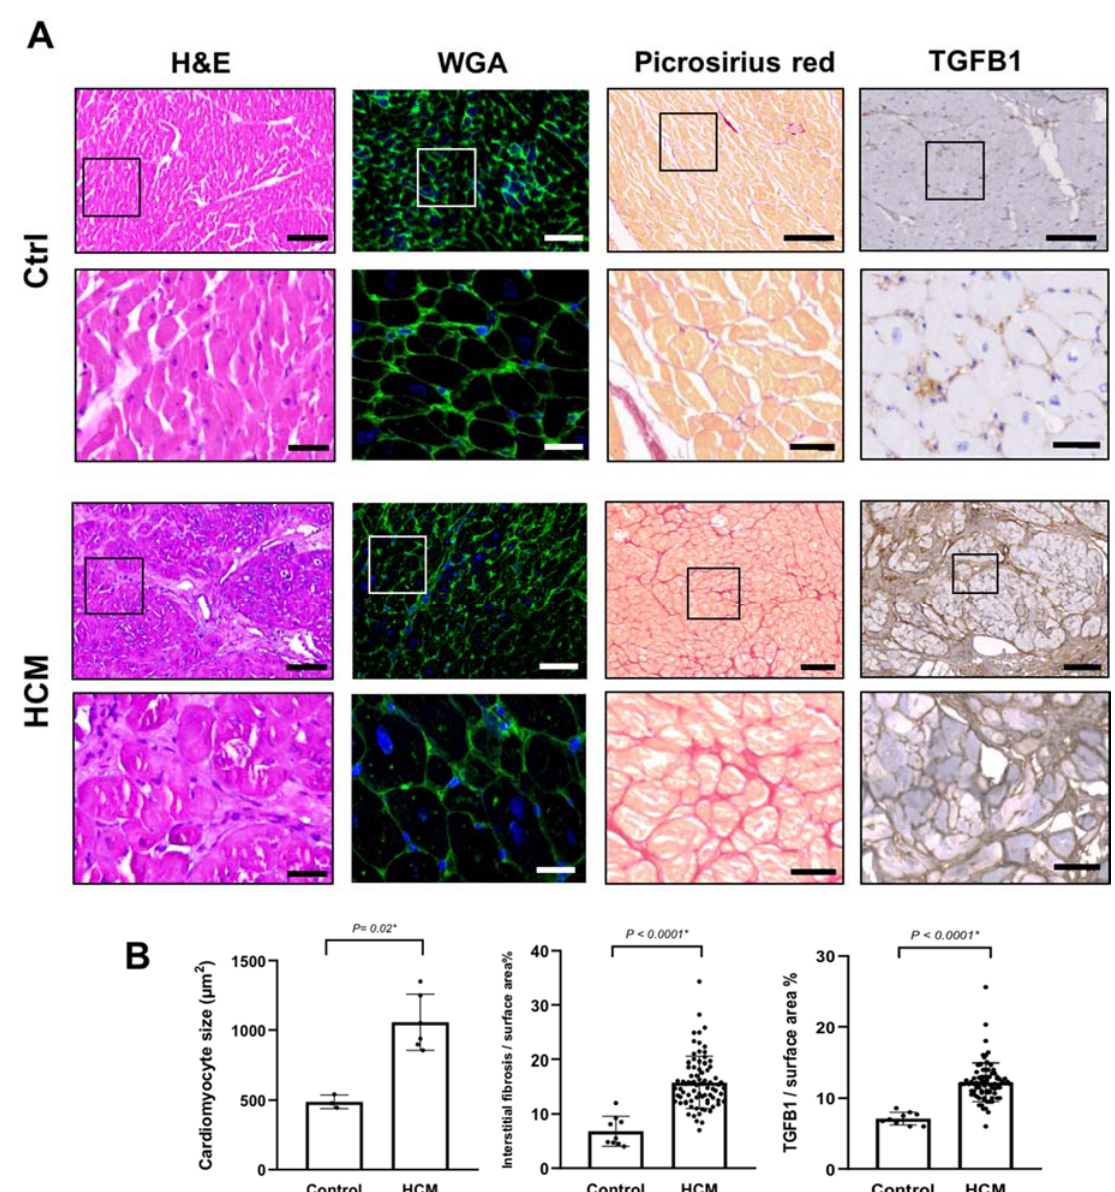
Figure 1. Histological characterization of HCM myectomy tissues ( A ) Histological characterization of HCM tissues compared to control tissues using hematoxylin and eosin (H&E) staining, WGA staining, Picro-sirius staining, and TGF β 1 expression, assessed by immunohistochemistry. Scale bars are 100 (overview) and 20 µ m (magnified insets). ( B ) Bar plots show a significant increase of cardiomyocytes size ( µ m 2 ) (6 HCM vs. 3 ctrls), interstitial fibrosis index (79 HCM vs. 9 ctrls), and TGF β 1 levels (79 HCM vs. 9 ctrls).